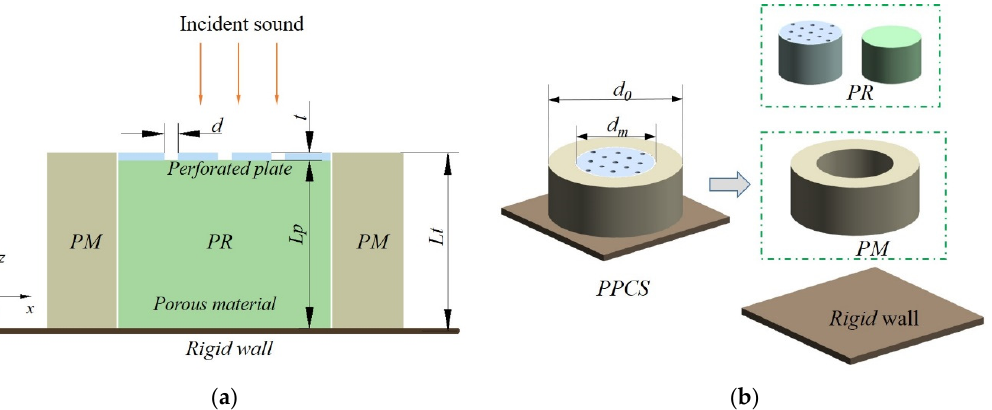
Figure 1. Schematic diagrams of the PPCS. ( a ) Two-dimensional cross-sectional view; ( b ) three-dimensional assembly view.